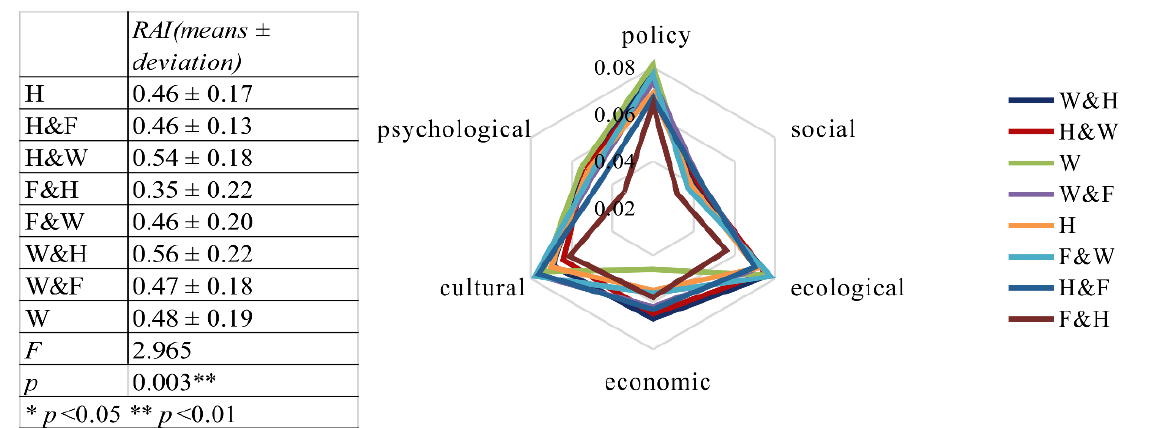
Figure 3. Result of analysis of variance and the adaptability of different livelihood types in different domains.